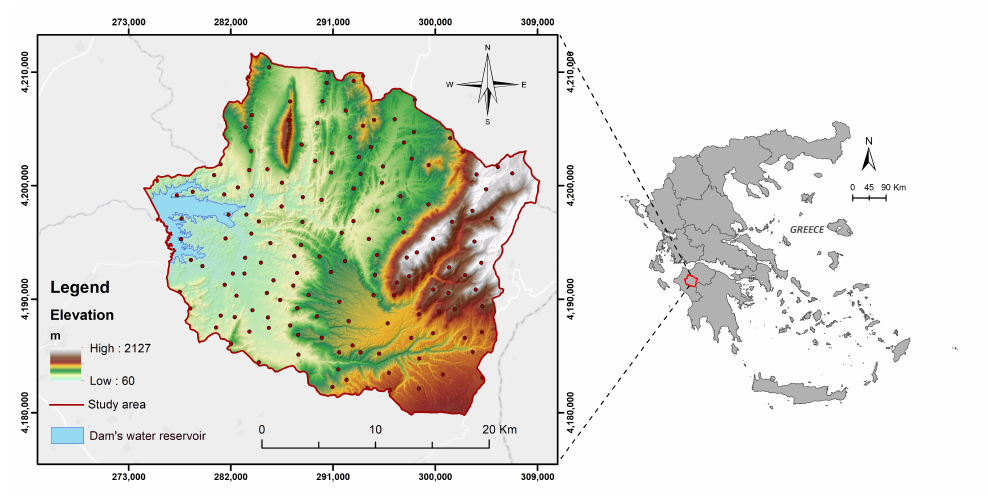
Figure 1. Drainage basin of the pilot area (Greek Geodetic Reference System—GGRS87). The drainage basin of the dam occupies an area of approximately 700 km 2 and the surface water is collected in a large reservoir of approximately 20 km 2 [50]. This research area was chosen because of its varied topography, which is of great importance regarding the computation of the LS factor. The altitude ranges from 49 to 2128 m m.a.s.l. and the max- imum slope inclination varies from 0 to 80 degrees. According to the Copernicus program “Corine Land Cover 2018”, the pilot area mainly consists of non-irrigated arable land (16%), complex cultivation (11%), land principally occupied by agriculture with significant areas of natural vegetation (25%), sclerophyllous vegetation (14%), and transitional woodland shrub (11%) (Figure 2). Conservation practices like contour farming, cropping, and terraces are mainly occurring in the pilot area.